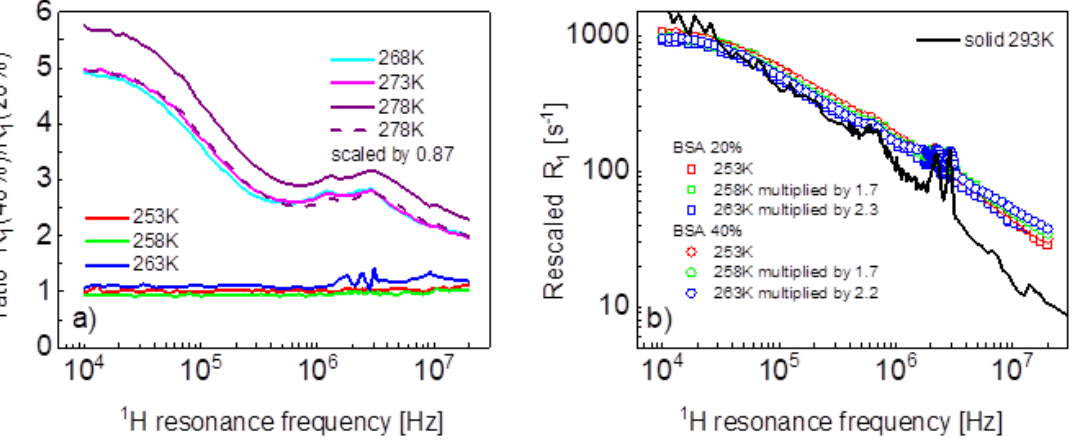
Figure 2. ( a ) Ratio between spin-lattice relaxation rates for BSA–water mixtures (40%wt of BSA and 20%wt of BSA); ( b ) rescaled spin-lattice relaxation data for BSA–water mixtures compared with data for solid BSA.